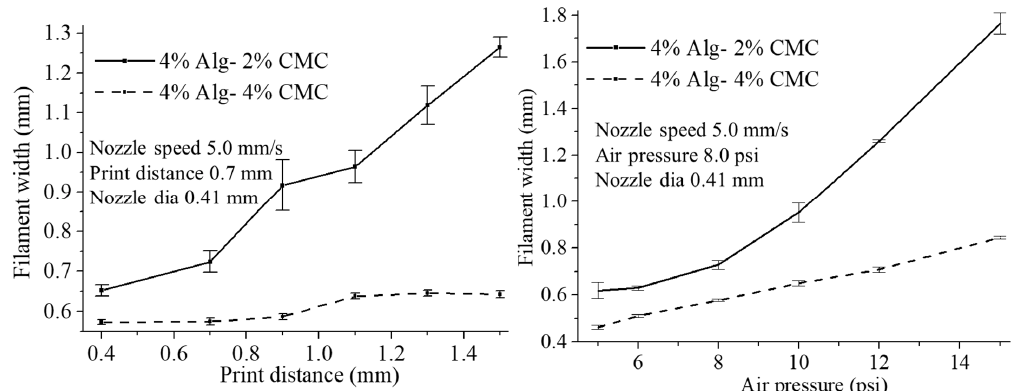
Figure 15. Effect of ( a ) Print distance, ( b ) Air pressure.